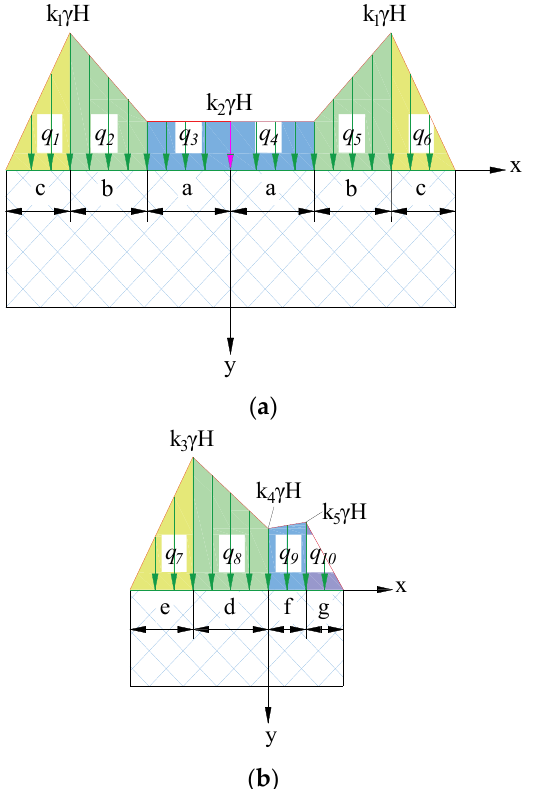
Figure 5. Coal pillar force models. ( a ) Wide coal pillar force model; ( b ) Narrow coal pillar force model. In the figure, ① – ⑩ are stress-concentrated areas of the coal pillar, and the vertical stress components of the floor rock mass are: